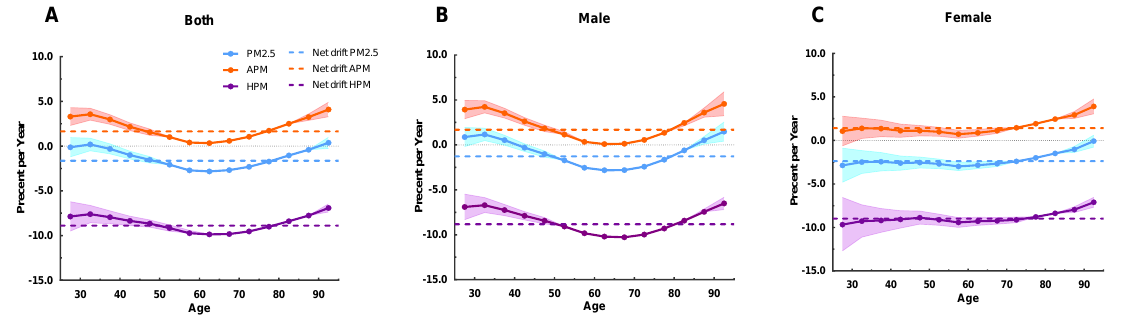
Figure 2. Local drift with net drift values of the mortality for IHD attributable to PM 2.5 (APM and HPM) in Jiangsu from 1990 to 2019. ( A ) Corresponding to both sexes; ( B ) corresponding to male; ( C ) corresponding to female. The dots and shaded areas denote percentage and their corresponding 95%CI.